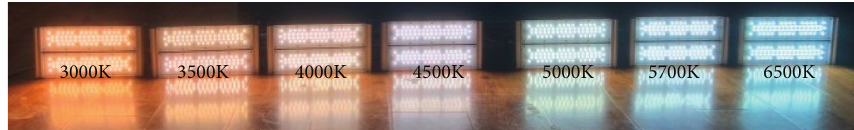
Figure 1: Seven kinds of LEDs applied in tunnel with different CCTs.